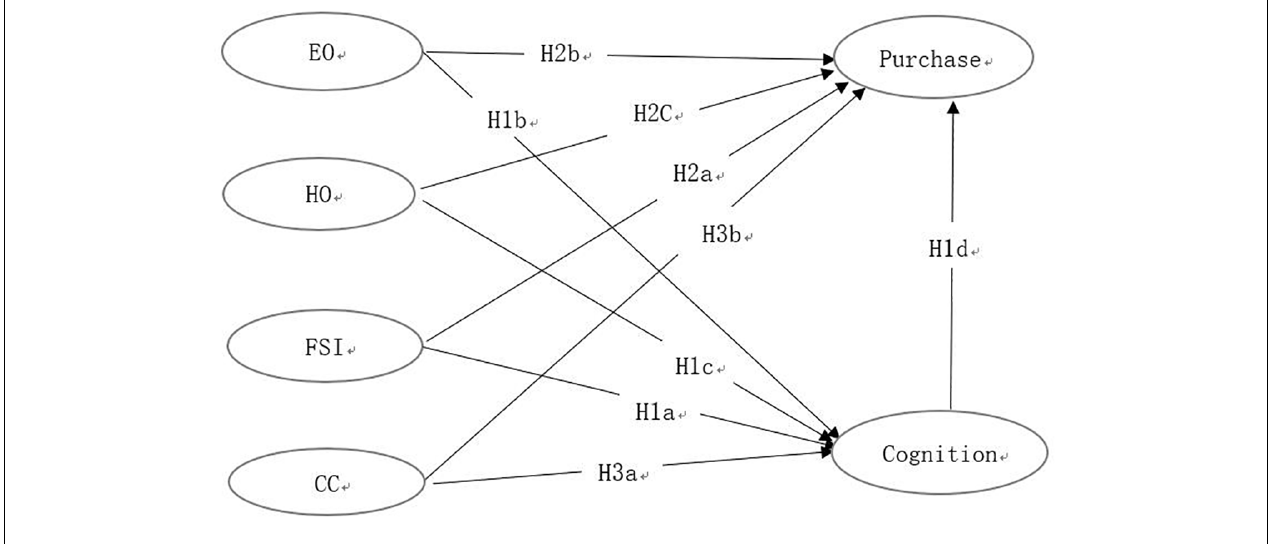
FIGURE 1 | Research